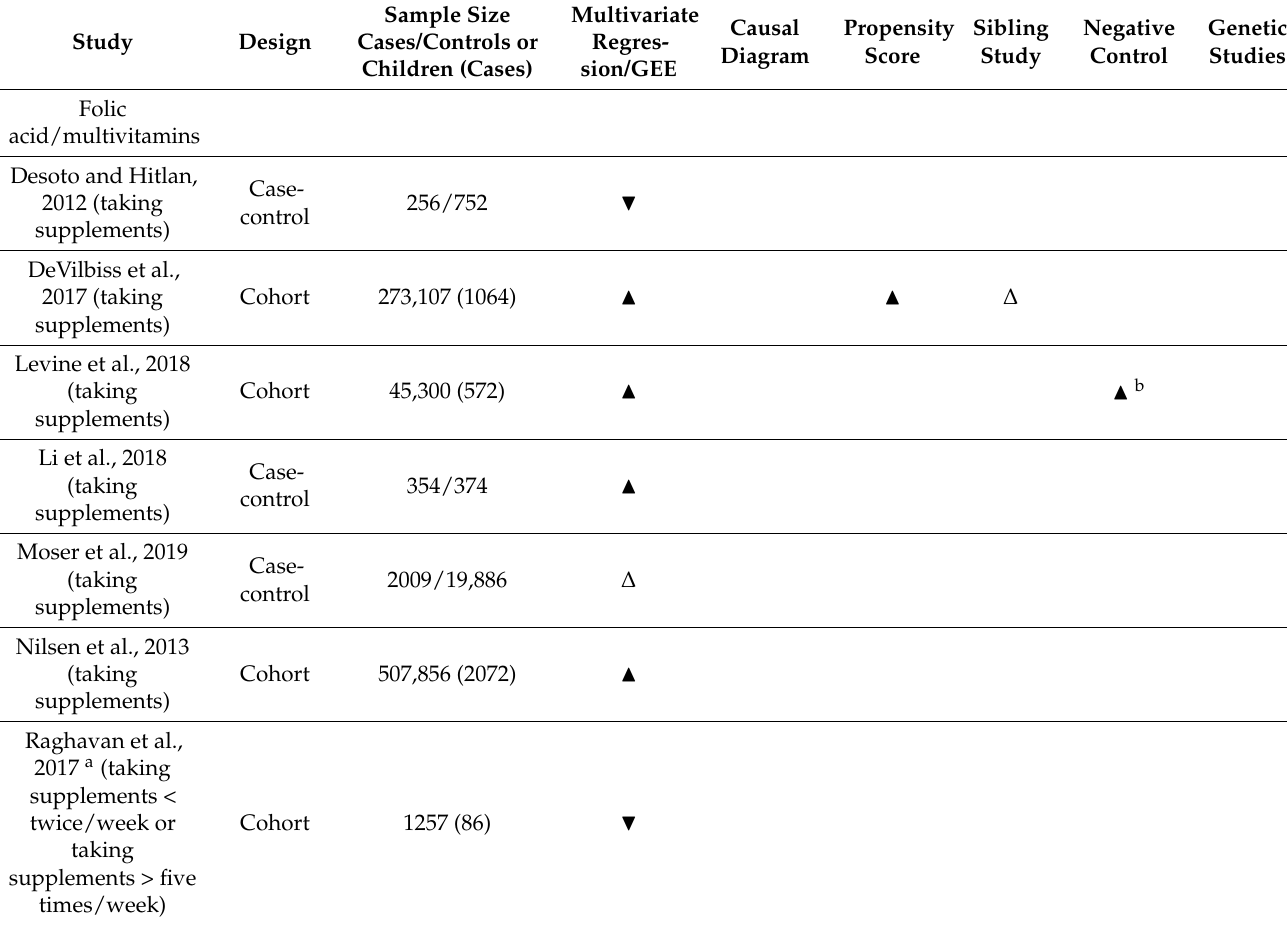
Table 4. Summary of causal approaches which demonstrates multivariate regression was commonly applied whilst all other approaches were infrequently